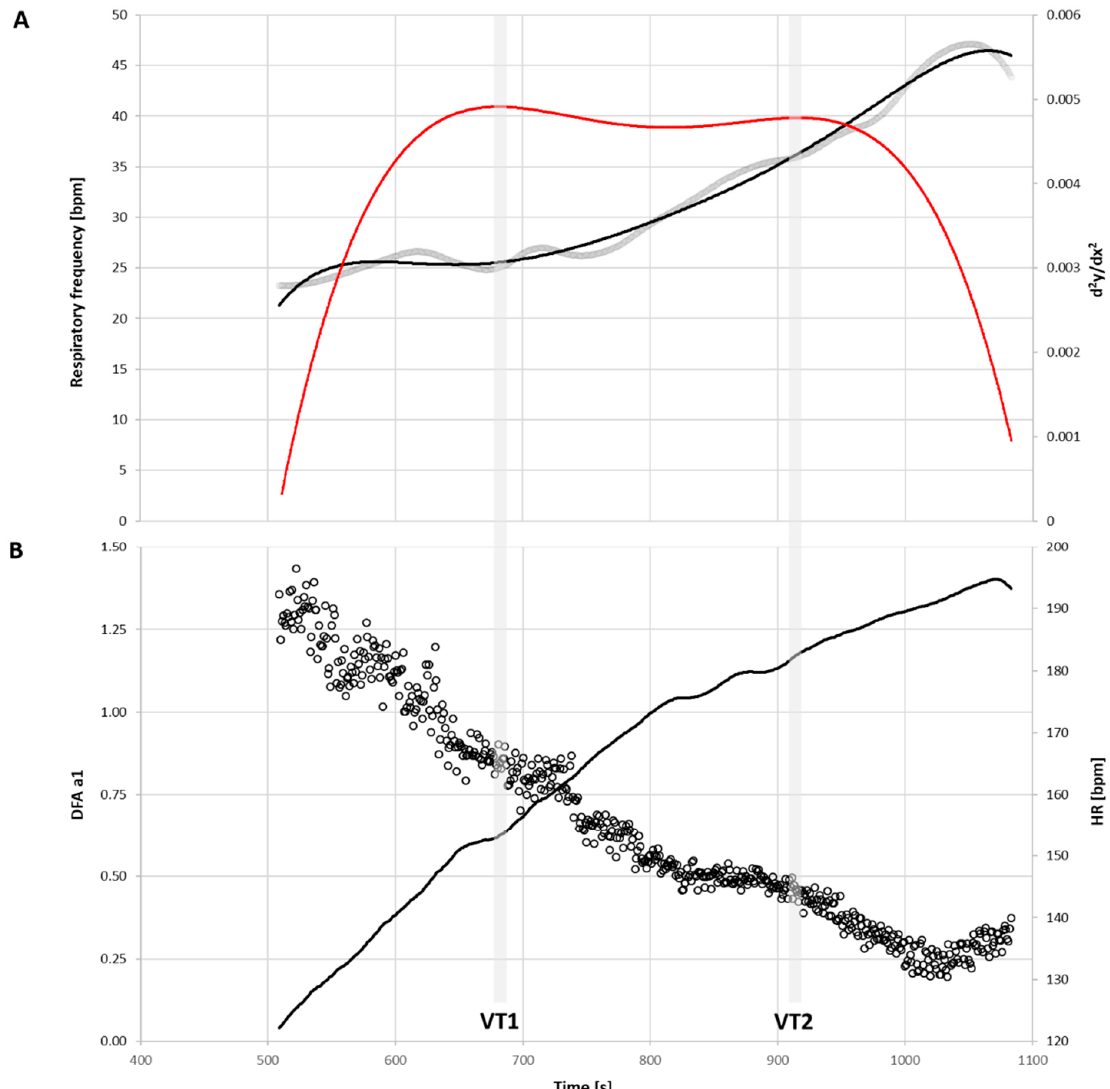
Figure 1. A 38-year-old male with a VO 2MAX of 43.1 mL/kg/min performing the incremental cycling ramp to exhaustion; vertical gray bars represent VT1 and VT2 respectively. ( A ) RF (bpm, gray line), the sixth order polynomial spline (black line) and the second derivative of the polynomial spline (d 2 y/dx 2 , red line). ( B ) DFA a1 over time (open circles) and HR (bpm, black line).